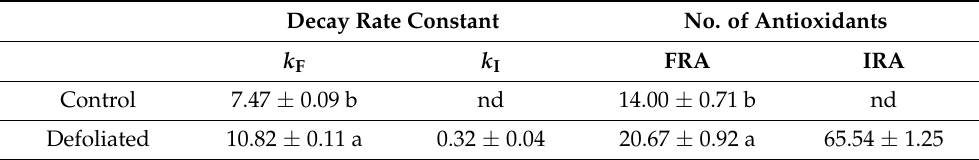
Table 4. Decay rate constants (M − 1 s − 1 ) and number of antioxidants (no. reduced DPPH• molecules × 10 19 g − 1 ) obtained from EPR decay kinetics of 3.3 mM